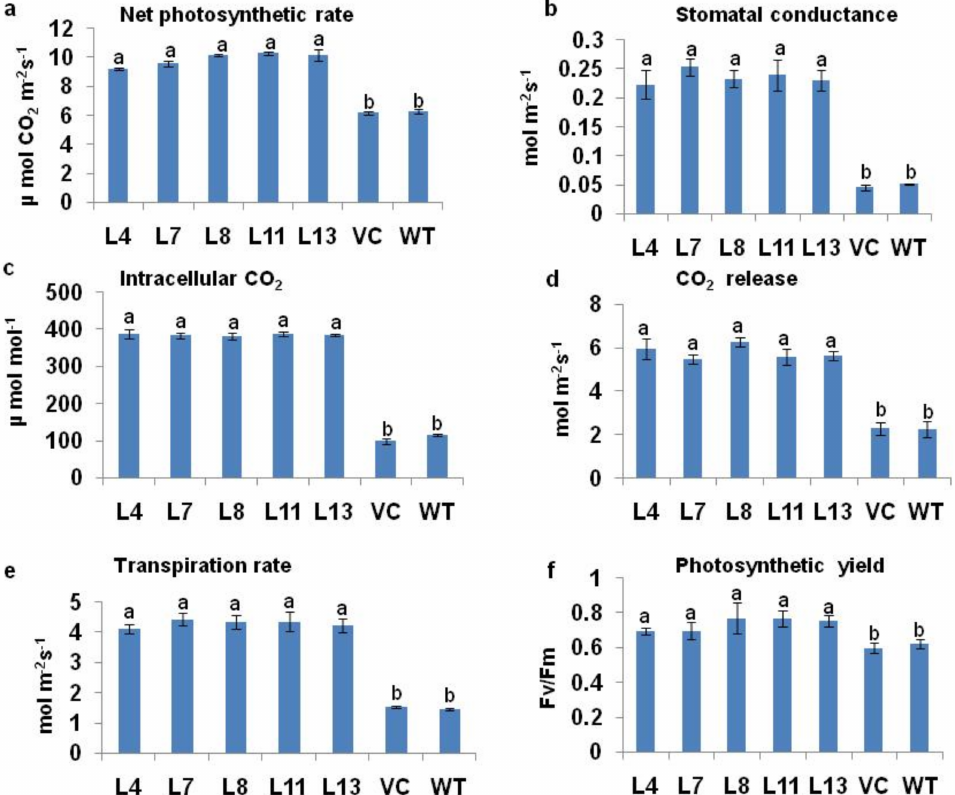
Figure 3. Measurement of photosynthetic characteristics and chlorophyll a fluorescence of WT, VC, and PDH45 marker-free transgenic lines (L4, L7, L8, L11 and L13) under 200 mM NaCl treatment. ( a ) Photosynthetic rate. ( b ) Stomatal conductance. ( c ) Intracellular CO 2 . ( d ) CO 2 release. ( e ) Transpiration rate. ( f ) Photosynthetic yield (Fv/Fm). Values are mean ± SE ( n = 3). Differ- ent letters on the top of bars indicate significant differences at p ≤ 0.05 level as determined by Duncan’s multiple range test